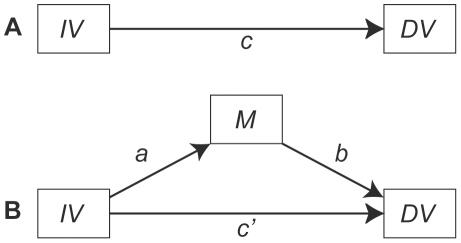
Diagram of classic mediation model.Panel A illustrates the total effect of the independent variable (IV) on the dependent variable (DV) as measured by regression coefficient c. Panel B shows the indirect effect of IV on DV via mediator M. The indirect effect is quantified as path a (IV→M) times path b (M→DV) or ab. The director effect is indicated by c′.